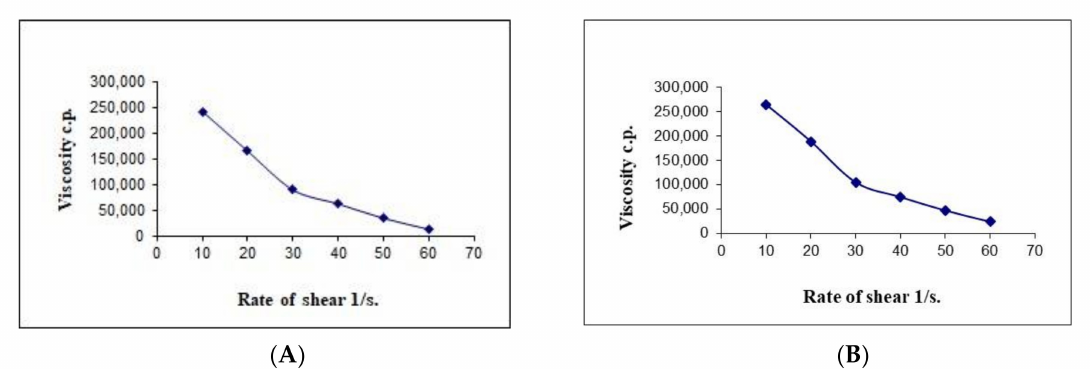
Figure 8. Representative plots of the rate of shear (G) versus the viscosity ( η ) for the ( A ) blank hyaluronic acid hydrogel and ( B ) HA-FS-NTF.